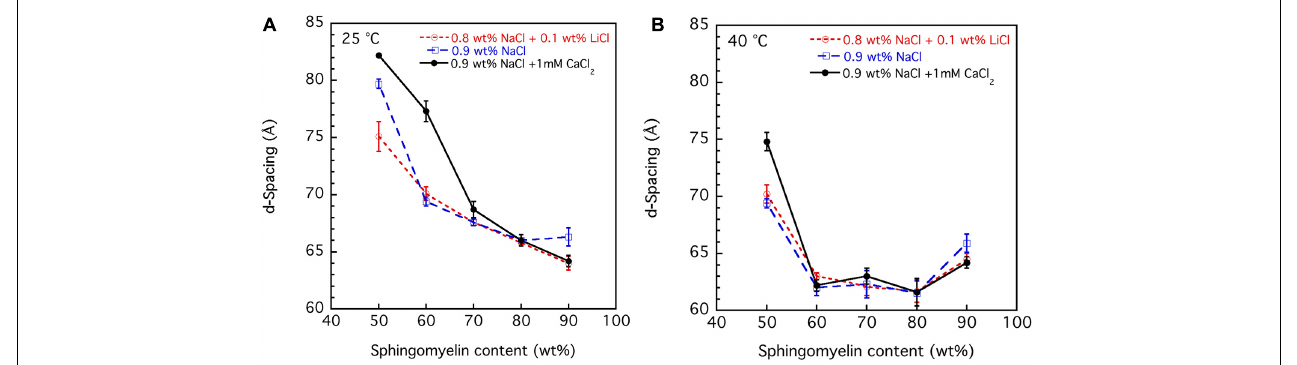
FIGURE 6 | The effect of salt solution composition, i.e., 0.9 wt% (154 mM) NaCl and 1 mM CaCl 2 , 0.8 wt% (137 mM) NaCl and 0.1 wt% (24 mM) LiCl, and 0.9 wt% (154 mM) NaCl, on the interlamellar spacing (d-spacing) obtained from SAXD data as a function of porcine brain sphingomyelin content recorded at two different temperatures, (A) 25 ◦ C and (B) 40 ◦ C. The obtained values are the mean values calculated from all observed first to fourth order of reflections. For the samples with the largest hydration (50 wt% lipid), the third and fourth order peaks are very broad, and therefore, the q value of the peak is uncertain. In those cases, we used only the first and second order reflections. The error bars in the graph are the standard deviation of the calculated mean values.